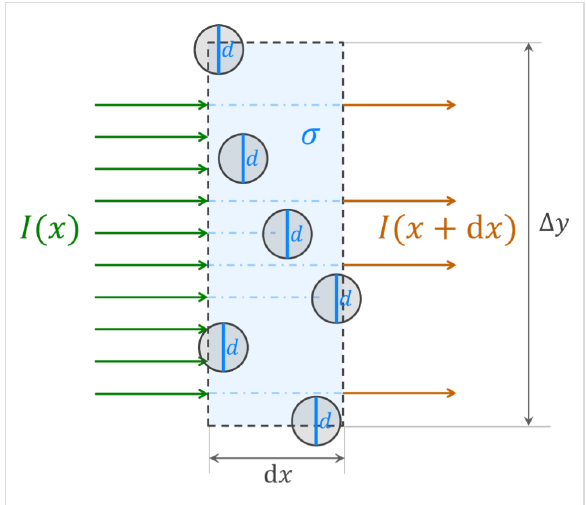
Figure 3: Top view schematic of the attenuation of a transverse flux I of molecules through the slice of a nanocylinder array of lateral dimen- sions Δ x × Δ y . For clarity, the diameters in the figure were kept con- stant instead of randomly distributed, which does not alter the result of the derivation.